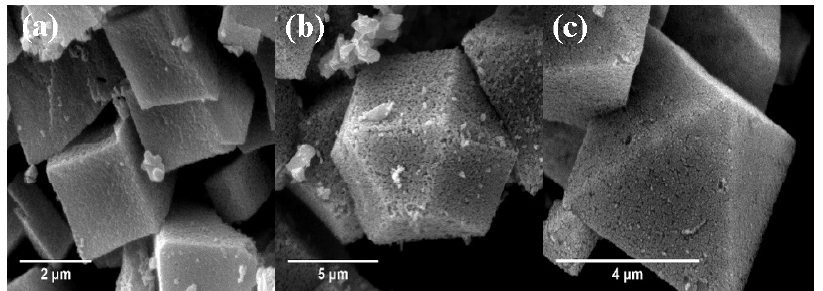
Figure 4. SEM images of prepared ZnO obtained from the various morphologies of IRMOF-3: cube ( a ), cuboctahedron ( b ), and octahedron ( c ).